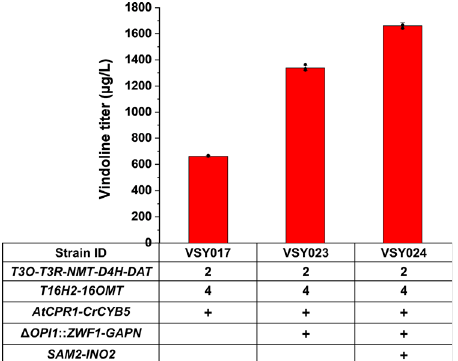
Fig. 5 Optimization of vindoline production through ER expansion and cofactor supply enhancement (NADPH and SAM). With VSY017 as the parent strain, OPI1 was deleted and INO2 was overexpressed for ER expansion, ZWF1 and GAPN were overexpressed to enhance NADPH supply, and SAM2 was overexpressed to increase SAM availability. All strains were cultured in SC with 2% galactose in the presence of 50 mg/L tabersonine. Error bars represent SD of biological triplicates ( n =